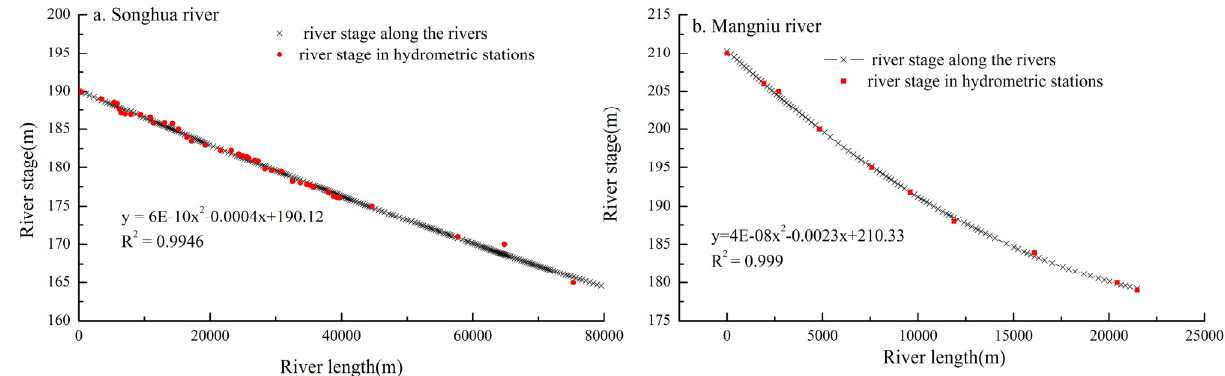
Figure10. River stage interpolation in Songhua River ( a ) and Mangniu River ( b ).